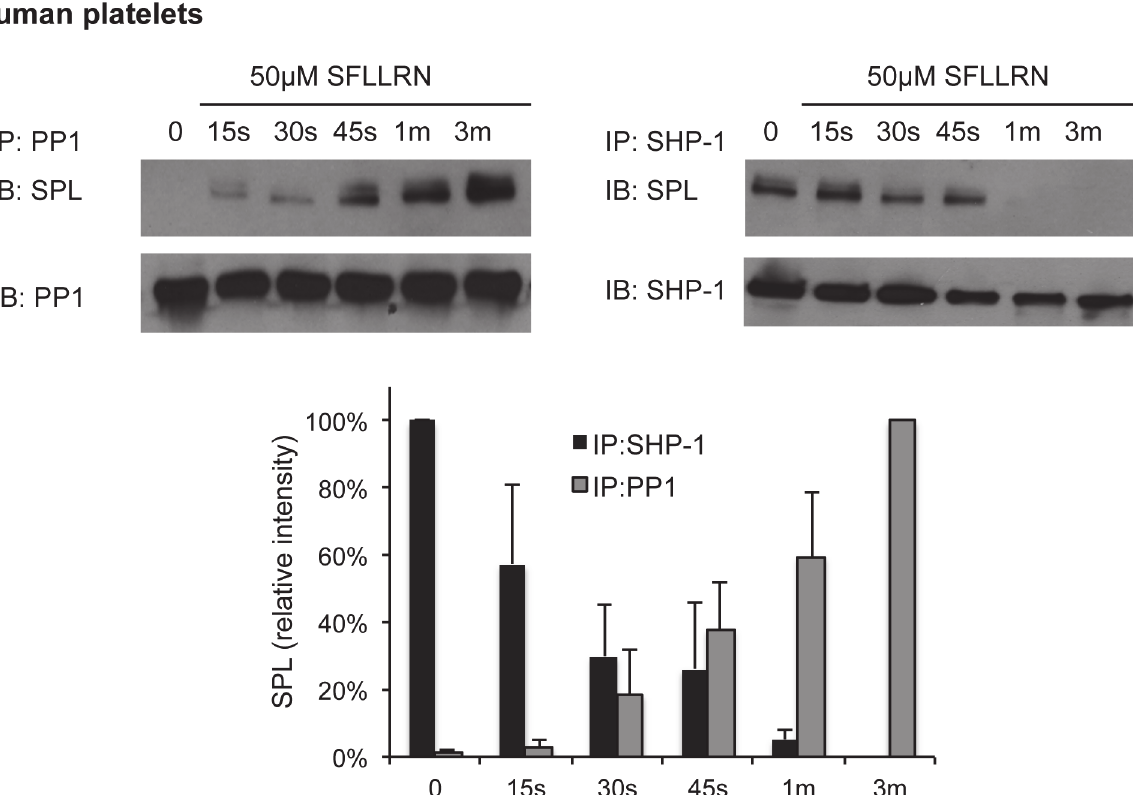
Fig 4. Temporal relationship between SHP-1 and PP1 binding to spinophilin in activated platelets. Human platelets were incubated with SFLLRN for each of the times indicated, after which proteins were precipitated with anti-pan-PP1 (E-9) or anti-SHP-1 and probed for spinophilin before being re-probed for PP1 or SHP-1 (mean ± SEM, N =